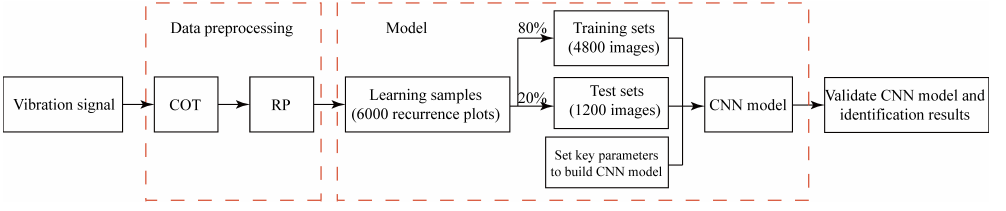
Figure 1. Combination of convolutional neural network (CNN) and recurrence plot (RP) in angular